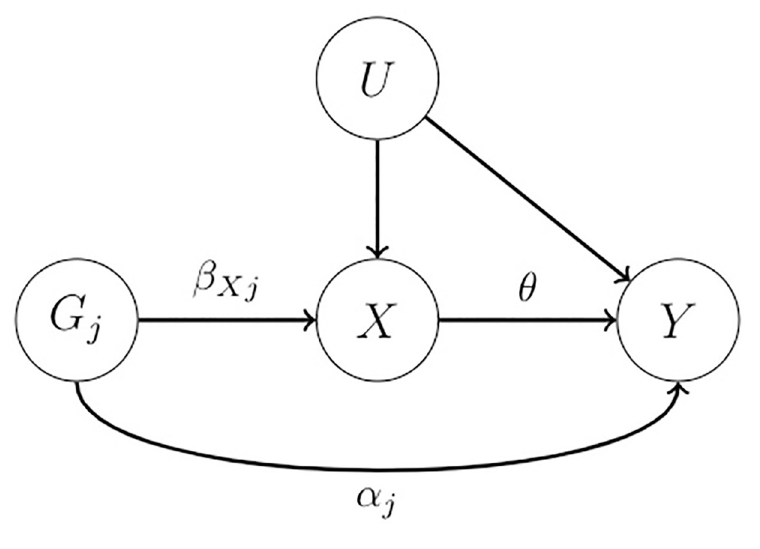
Fig 1. The true causal